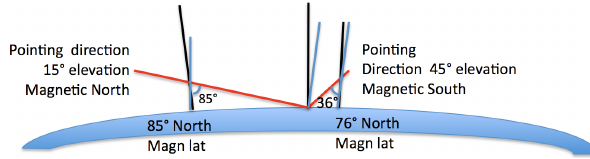
Fig. 2. Configuration of the experiments. The black lines indicate the local zenith. The blue lines are the local magnetic field direc- tions. The red lines are the observation directions. The angles are shown where the line of sight intersects the magnetic field at 210km